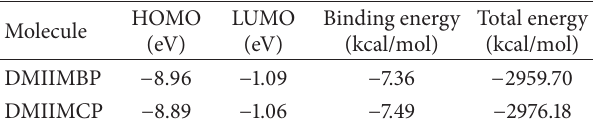
Table6:TheenergyvaluesoftheligandsDMIIMBPandDMIIMCP.